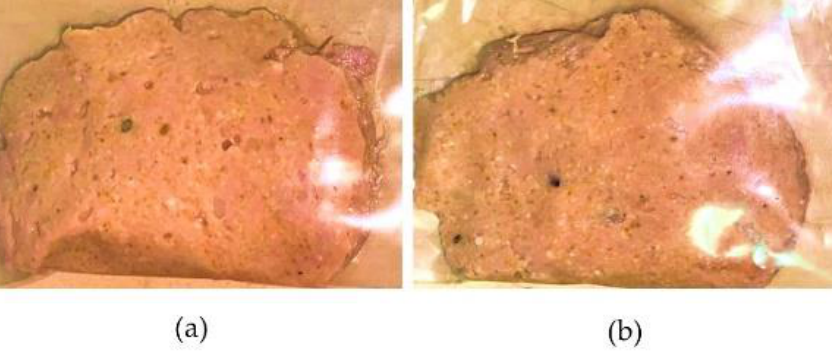
Figure 4. Physical appearance of the developed burger patty at 7 ( a ) and 14 ( b ) days after preparation at 4 °C.